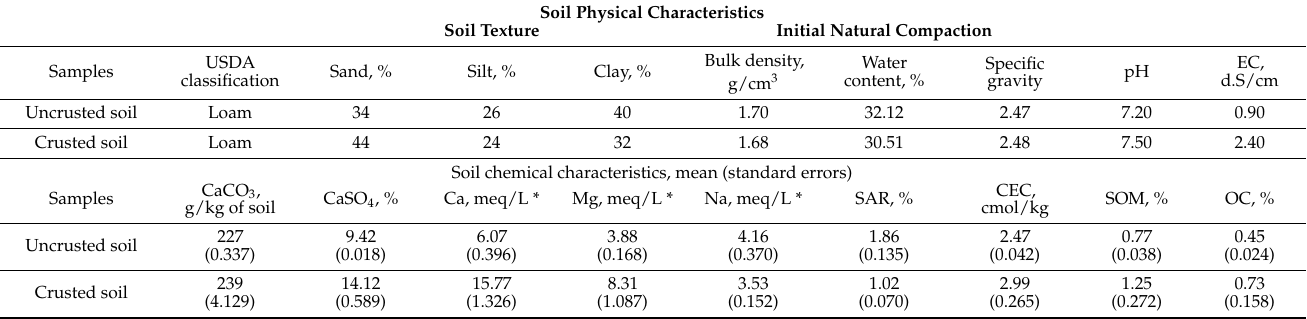
Table 1. Results of examination the physical and chemical properties of the undisturbed crusted and uncrusted soils used in this